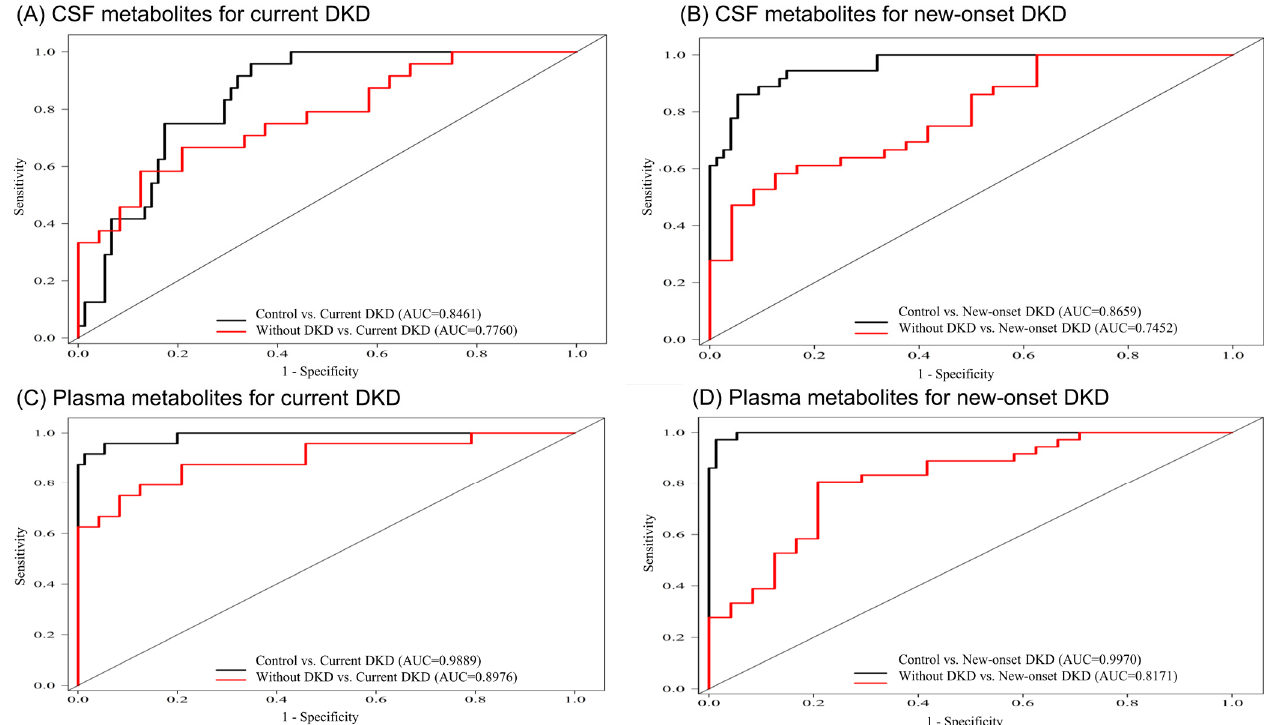
Figure 3. Area under curve of the significant altered metabolite combinations in the CSF samples for discriminating patients with ( A ) current DKD; ( B ) new-onset DKD; and metabolite combinations in the plasma samples for discriminating patients with ( C ) current DKD; ( D ) new-onset DKD, from patients without DKD and the control participants.